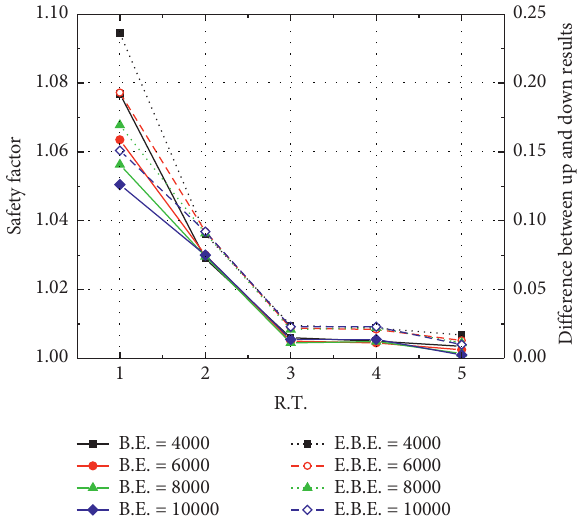
Figure 3: Slope stability under different initial grid elements and remeshing